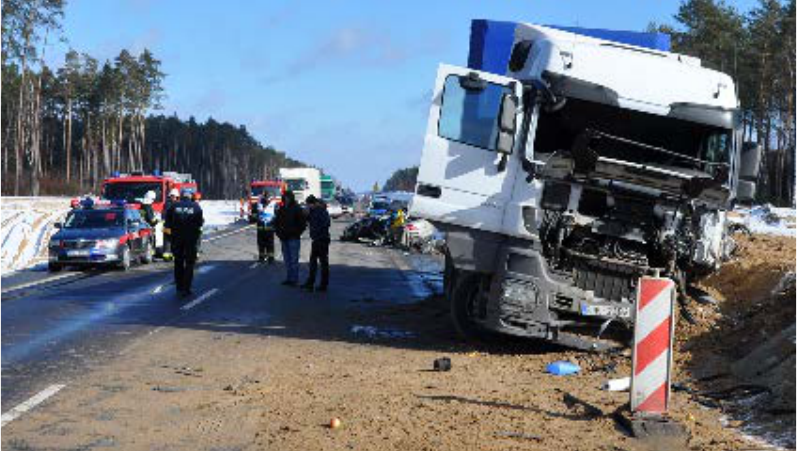
Figure 1. Photo of the area of the accident site. Lorry truck in the foreground, and cars in the back- ground center. background